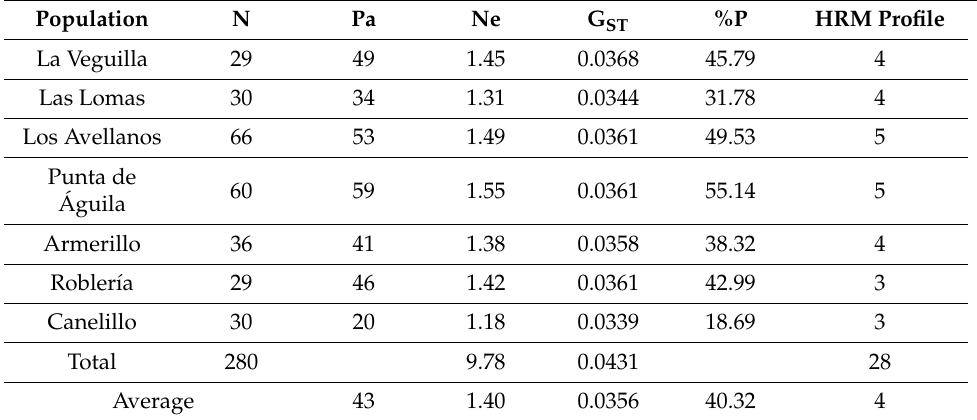
Figure 7. Discrimination of seven unique genotypes of G. avellana using microsatellite marker Ga38. ( A ) Normalized HRM graph of seven unique genotypes of each population of G. avellana Mol. ( B ) Difference plot of those seven unique genotypes, HRM melting curves (displayed graph from top to bottom) Armerillo (Red), Punta de Águila (Burgandy), La Veguilla (Sky-blue), Los Avellanos (Light blue), Las Lomas (Green), Canelillo (Purple), and Roblería (Yellow). Table 3. Genetic diversity estimates at eight EST-SSR markers for seven populations of G. avellana Mol. N: sample size, Pa: Private alleles, Ne: effective number of alleles, G ST : Genetic differentiation coefficient between populations, %P: percentage of polymorphic loci, and HRM Profile = Maximum HRM profiles found in each population (not exclusive to each population).